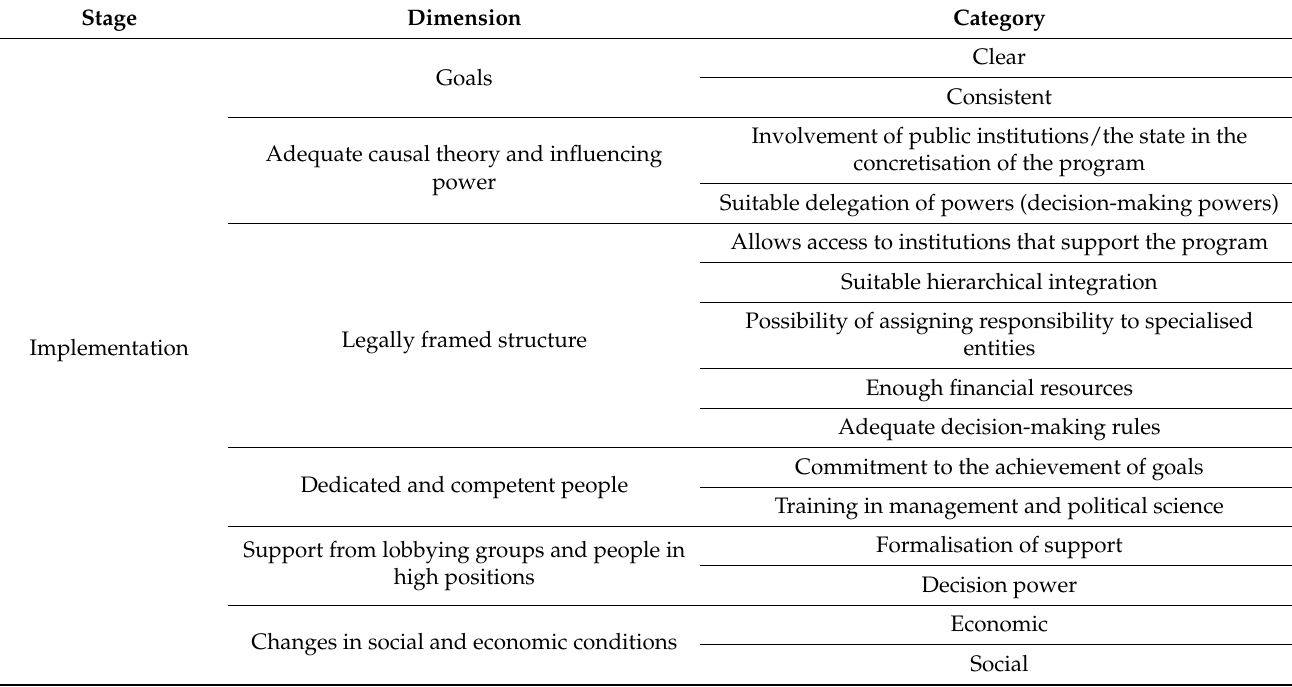
Table 3. Dimensions and categories of the implementation stage.